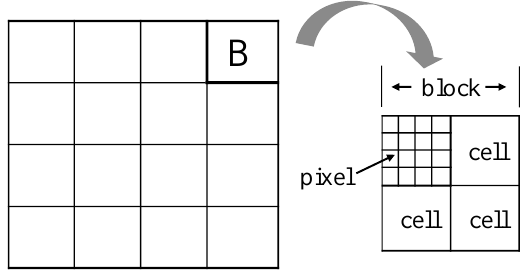
Figure 5. The relationship between blocks and cells. The symbol B represents a block, which contains four cells.